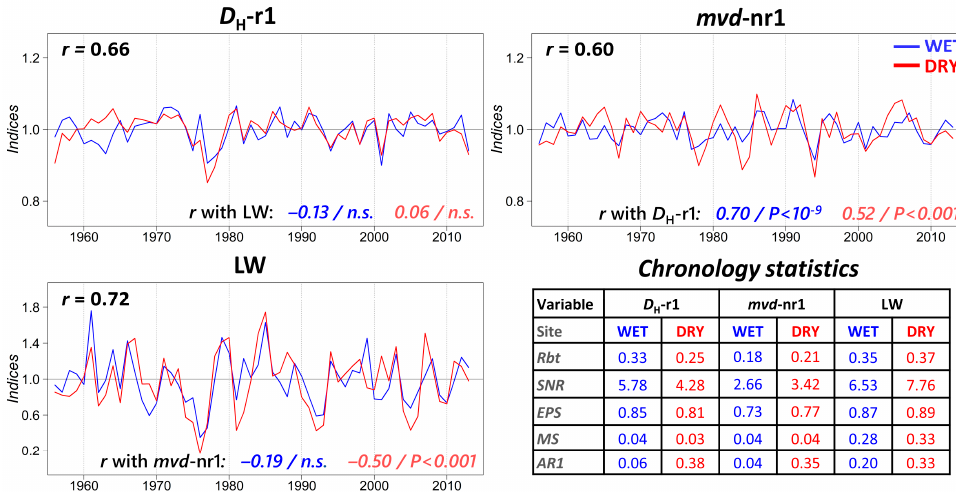
Figure 2. Comparison between site and variable chronologies, with their corresponding descriptive statistics, for hydraulically weighted diameter of first row vessels ( D H -r1), mean vessel diameter outside that row ( mvd -nr1), and latewood width (LW) along the common interval 1956–2013. Rbt : mean correlation between trees; SNR : signal-to-noise ratio, EPS : expressed population signal; MS : mean sensitivity; AR1 : first order autocorrelation coefficient.